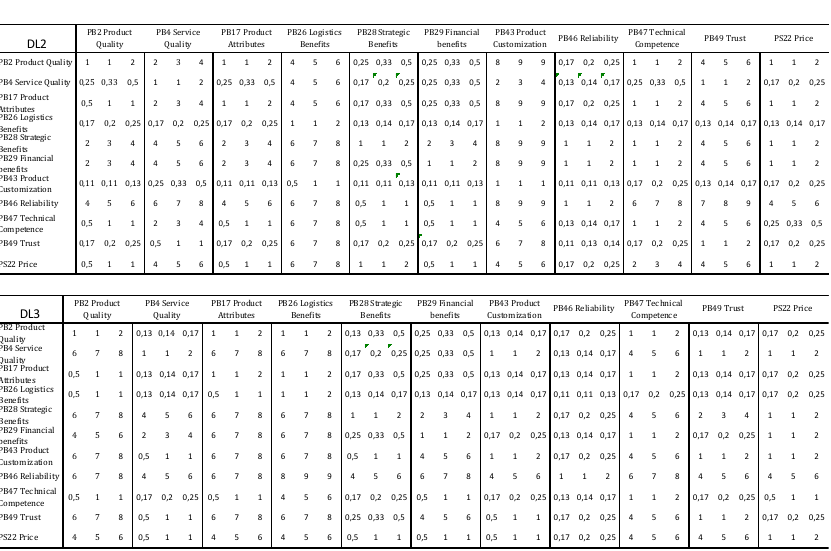
Table 3. Fuzzy comparison matrix with respect to DL2 and DL3